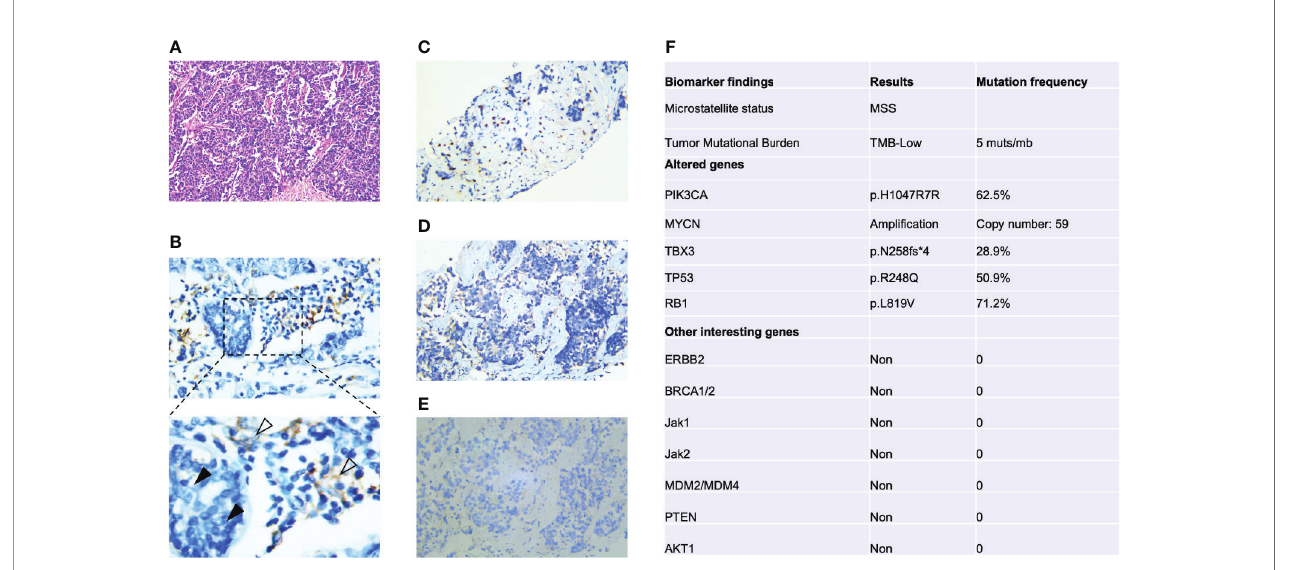
FIGURE 2 | Immunohistochemical analysis of PD-L1 expression and next-generation sequencing of pretreatment tumors. (A) Hematoxylin-eosin staining. (B) Immunohistochemical analysis of PD-L1 expression was conducted with an anti-PD-L1 antibody (Dako PD-L1 22C3 PharmDx assay). PD-L1 was not expressed in tumor cells (black arrow), whereas positive staining for PD-L1 in peritumoral lymphocytes was observed (white arrow). Immunohistochemical detection of CD3+ (C) , CD4+ (D) and CD8+ cells (E) . (F) Next-generation sequencing results based on the FoundationOne CDx assay. The test analyzes 324 genes as well as genomic signatures, including microsatellite instability and tumor mutation